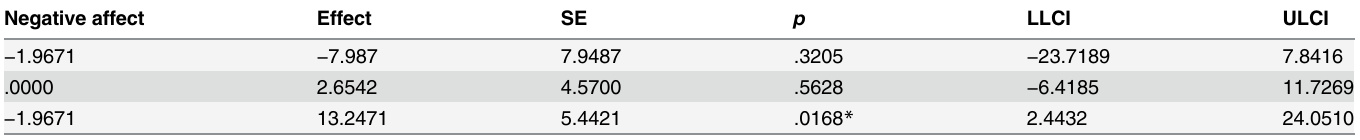
Table 2. The effect of 2013 Boston Marathon Bomb prime on DIFI. Negative